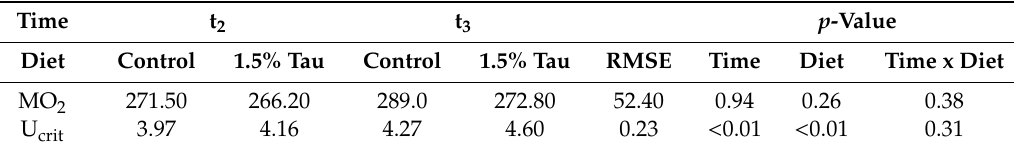
Table 3. E ff ects of diet on metabolic responses to exercise and critical swimming speed performance at t 2 and t 3 in the European seabass.